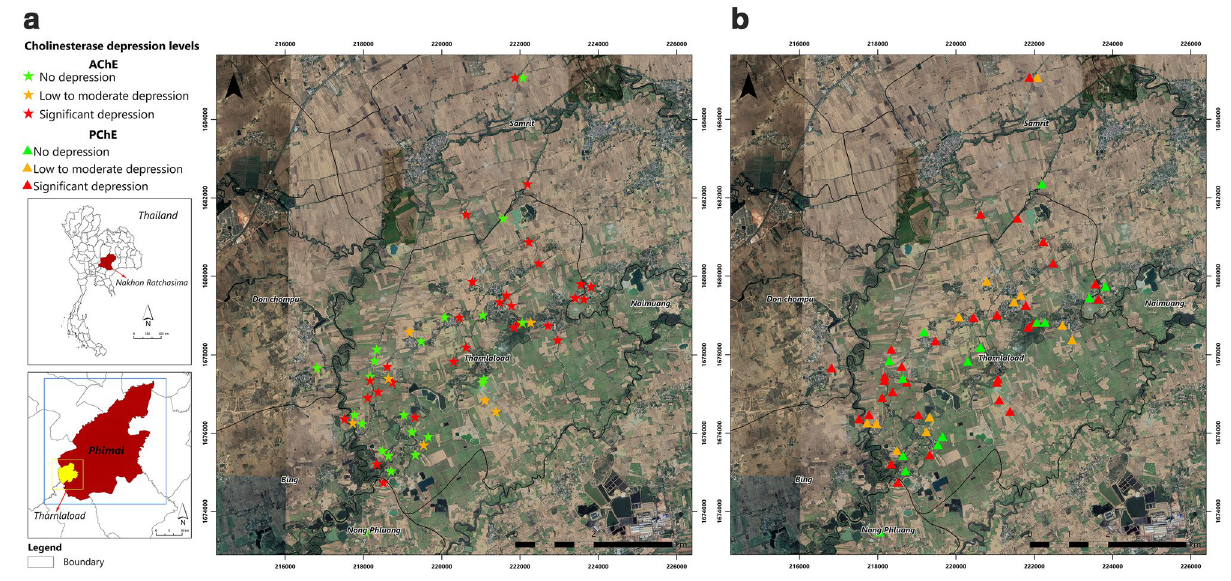
Figure 2. AChE ( a ) and BuChE ( b ) depression levels presented on the GIS maps during the active rice farming period. Figure was created by the ArcGIS version 10.8 software (Environmental Systems Research Institute, Inc, USA, version 10.8, http:// www. esri. com).